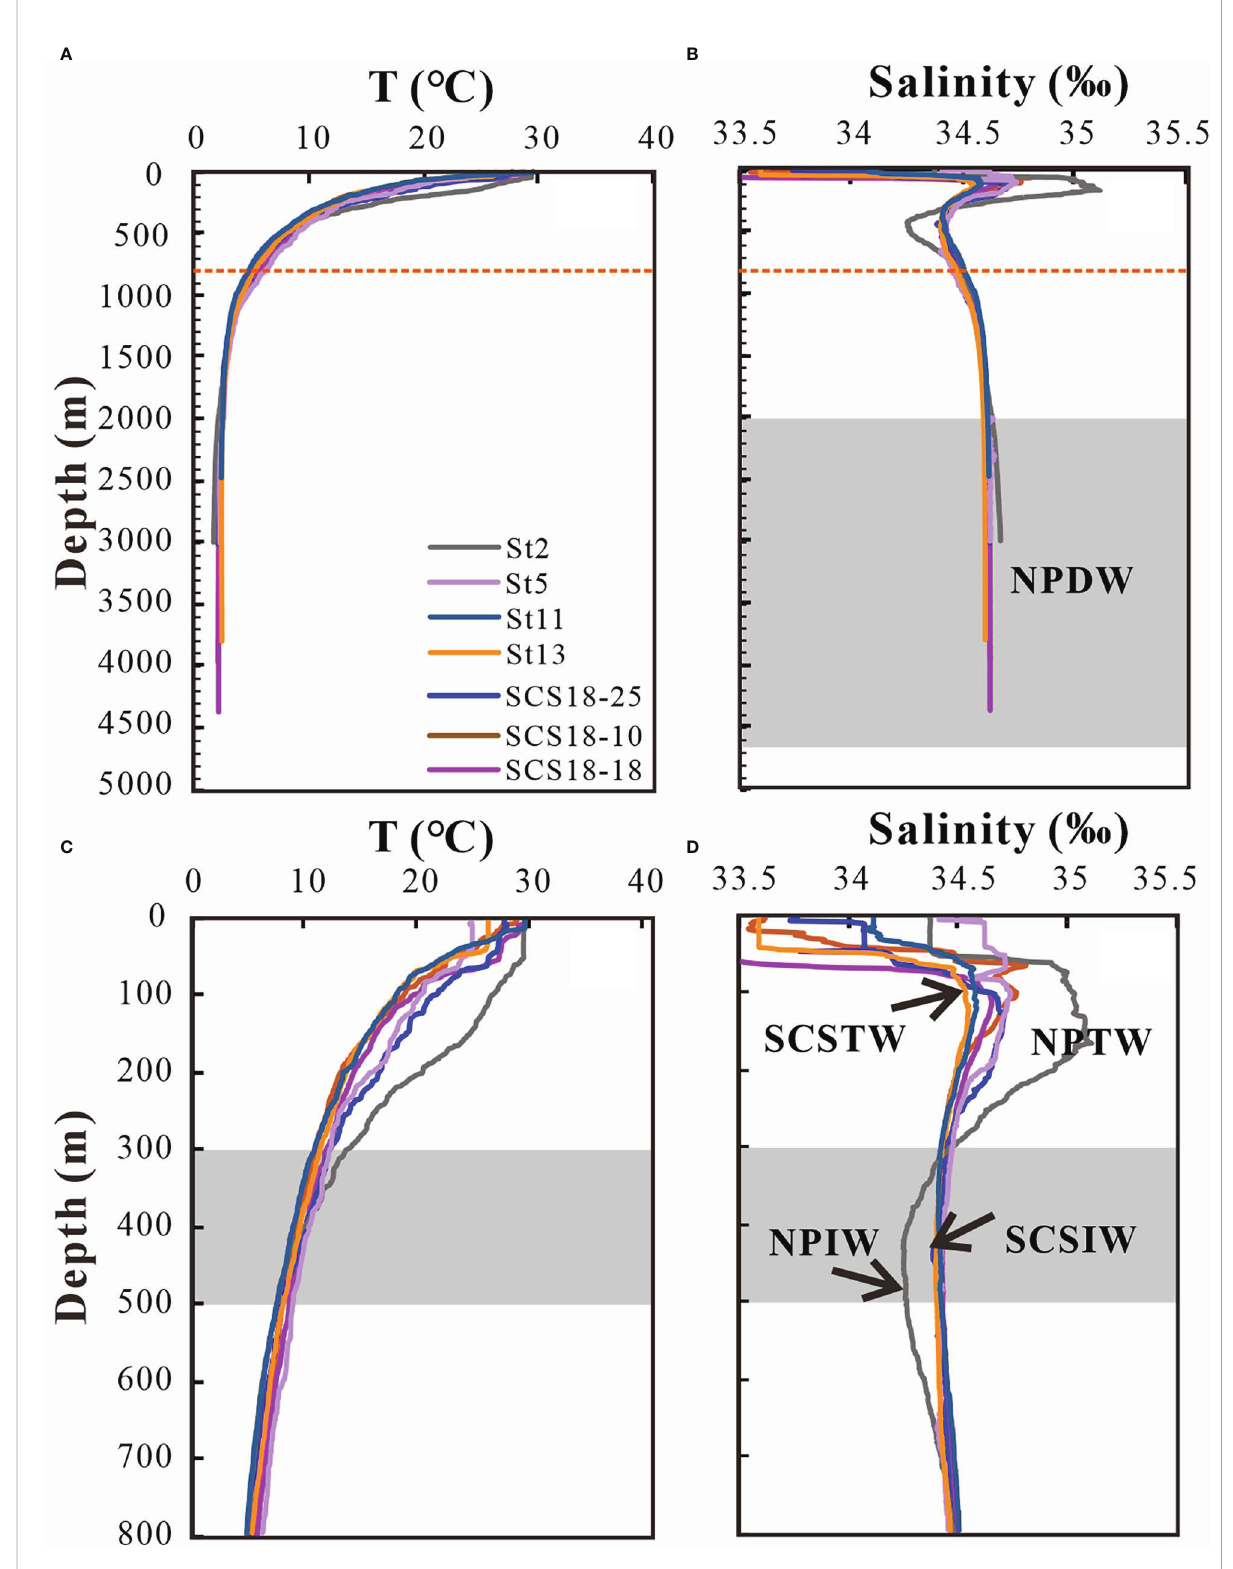
FIGURE 2 Physical water properties (A – D) at our sampling stations over the northern and central SCS. Data of St2, St5, St11, and St13 stations (Wu et al., 2015) are combined with our data and